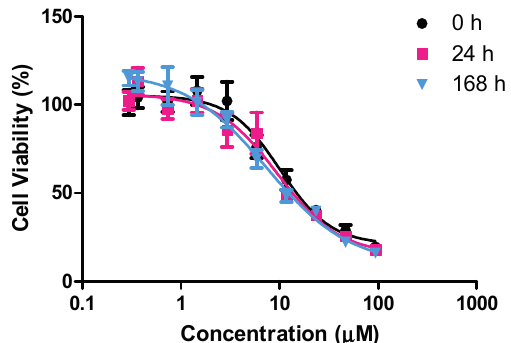
Figure 3. Dependence of human colon HT-29 cell viability on administered concentration of LTi following pre-incubation in complete cell growth medium for varying periods (h) prior to administration to the cells. IC 50 values ( μ M), as the mean ± SD of at least three independent experiments conducted on different days, each with at least three replicates: 0 h: 9 ± 4; 24 h: 9 ± 4; 168 h: 8 ± 2.